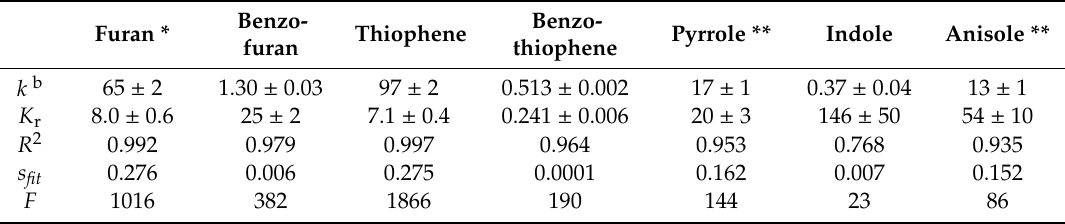
Table 2. Rate constants, k , and relative sorption equilibrium constants, K r , of the BEA catalytic reactions. Shown also are the fits’ statistical figures of merit a .